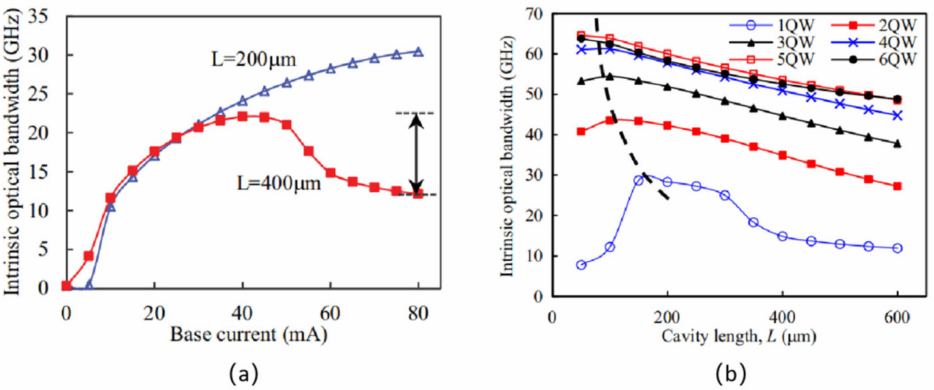
Figure 5. ( a ) Variation in bandwidth with base current at different cavity lengths. ( b ) Variation in bandwidth with cavity length under different QW numbers